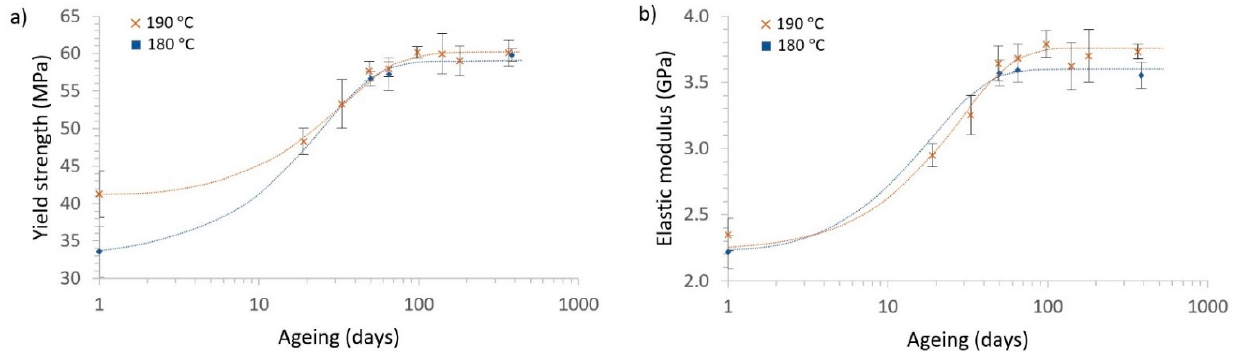
Figure 10. Evolution at different ageing times and printing temperatures (180 to 190 °C), with the corresponding fitting equations—logistic model–, for ( a ) the yield strength and ( b ) the elastic modulus.